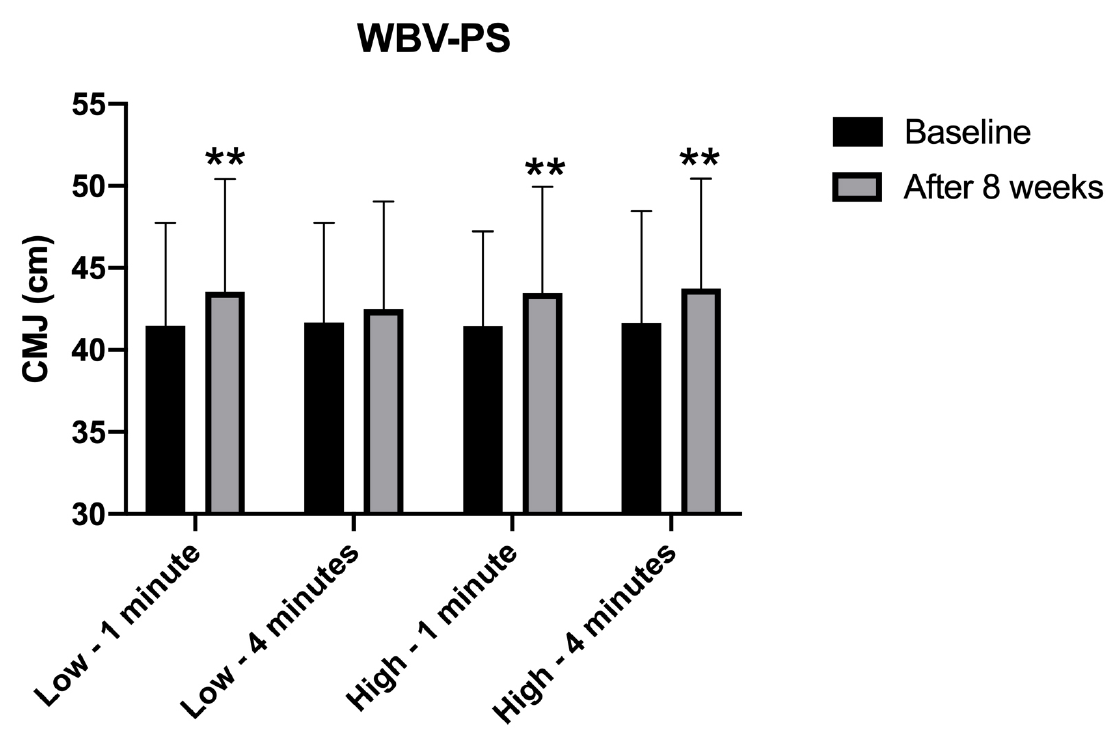
FIGURE 3. Differences between baseline and after post-activation potentiation protocols in terms of volume and rest duration for countermovement jump (CMJ) in parallel squat onto a whole-body vibration platform (WBV-PS). ** Significant differences ( p < 0.001) when comparing post-protocol results with baseline.